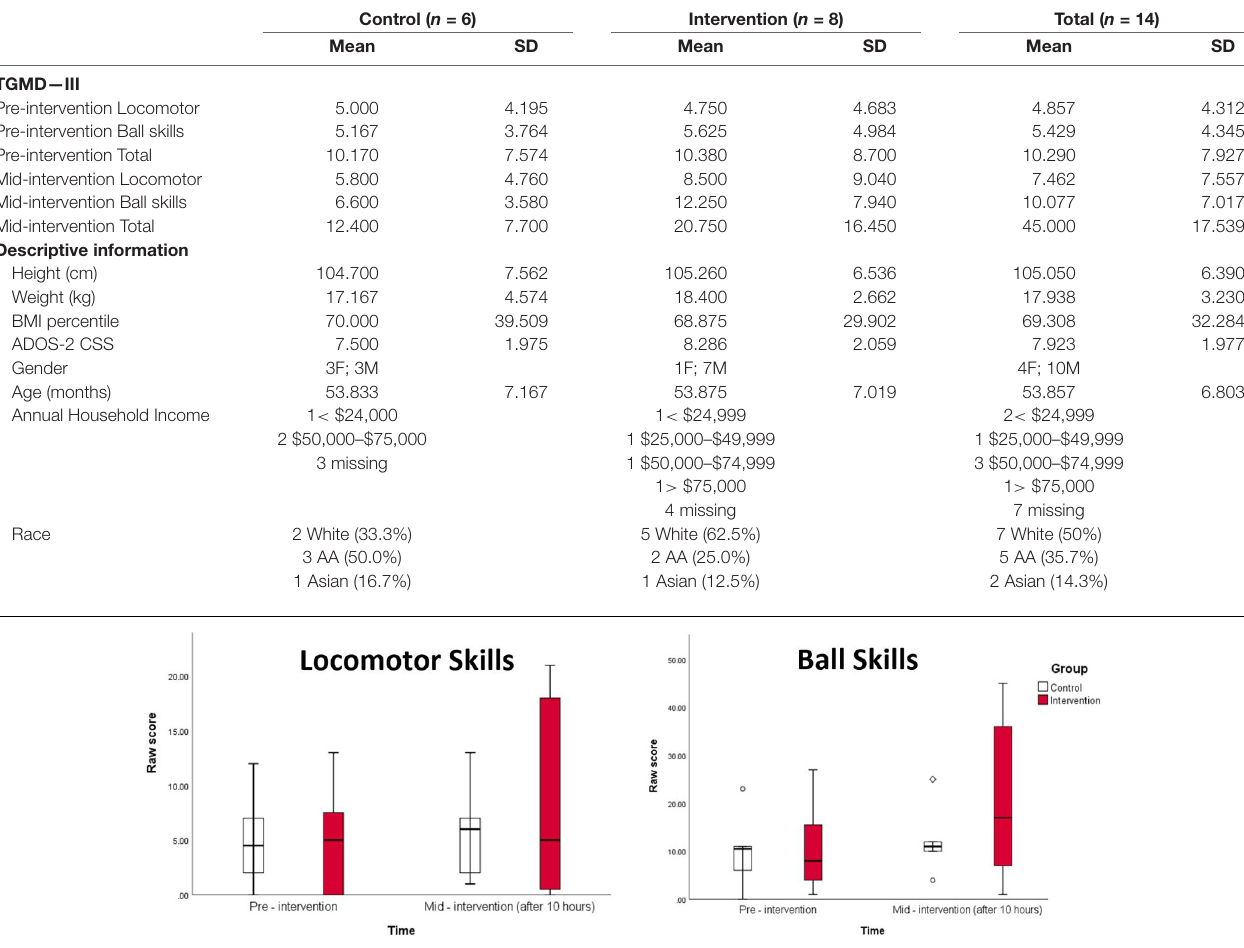
TABLE 1 | Comparison of control and intervention group TGMD—III raw scores from baseline to mid-intervention by repeated measures MANOVA, and baseline descriptive information.